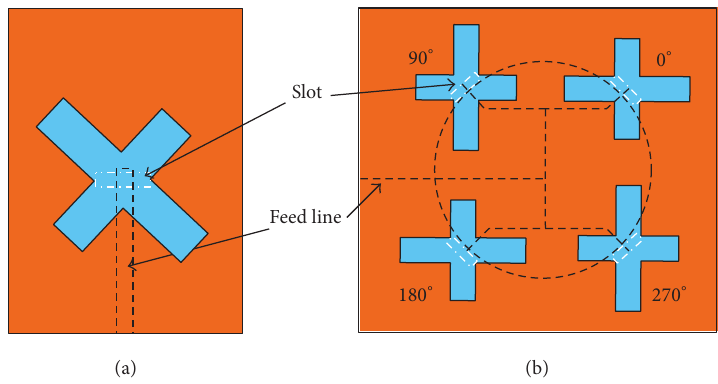
Figure 7: Cross-shaped DRA (a) and a sequentially fed cross-shaped DRA array (b) as suggested in [12].